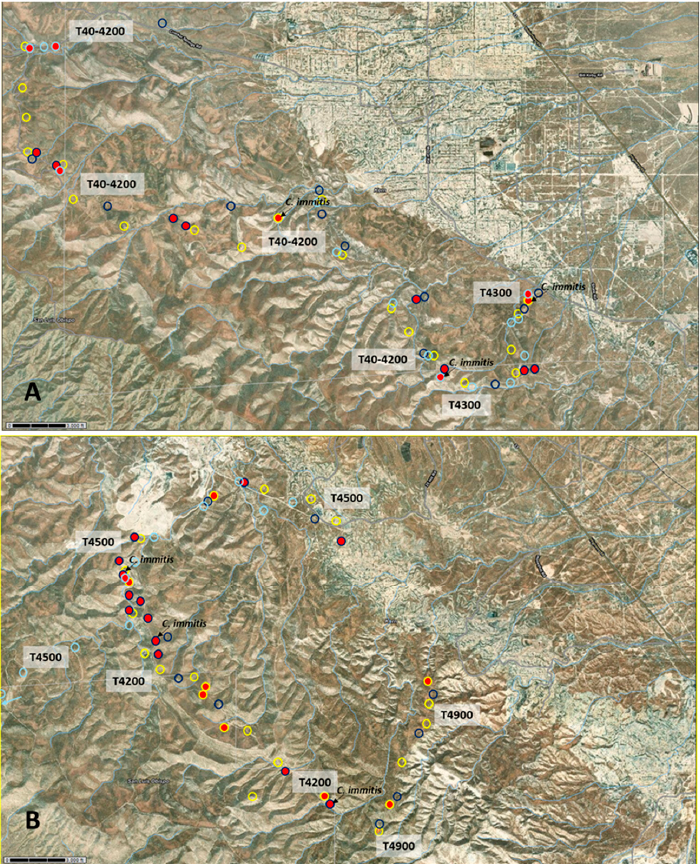
Figure 6. Locations of sampling sites along trails. ( A ) T4500, T4200, and T4900 in the southern sampling area. ( B ) Trails T40-4200 and T4300 in the northern sampling area (2018: dark blue circles, 2019: light blue circles, 2021: yellow circles). Sites where Coccidioides spp. were detected are indicated by circles filled in red. In addition, sites where C. immitis was detected are labeled.